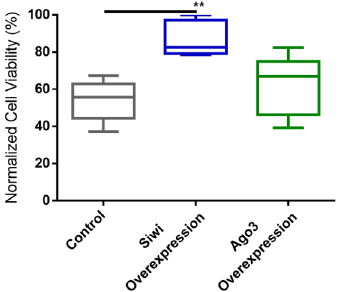
Figure 4. Cricket Paralysis Virus (CrPV)-induced mortality upon overexpression of Siwi and Ago3 in High Five cells. Cells were transfected with overexpression constructs containing the entire ORF of Bm-siwi and Bm-ago3 . The control group was transfected with the pEA-pac control vector containing the ORF of the puromycin resistance gene. The transfected cells were infected with CrPV (MOI25), or treated with PBS, and the viability was assessed after 48 h. The graphs depict the normalized cell viabilities, i.e., viabilities of the CrPV-infected cells normalized to the viabilities of the PBS-treated cells. Each box depicts the interquartile range, with the inner line representing the median. The whiskers represent the minimum and maximum values. Statistical analysis (Mann–Whitney test) was performed in GraphPad Prism 6 (** p < 0.005; n ≥ 5).